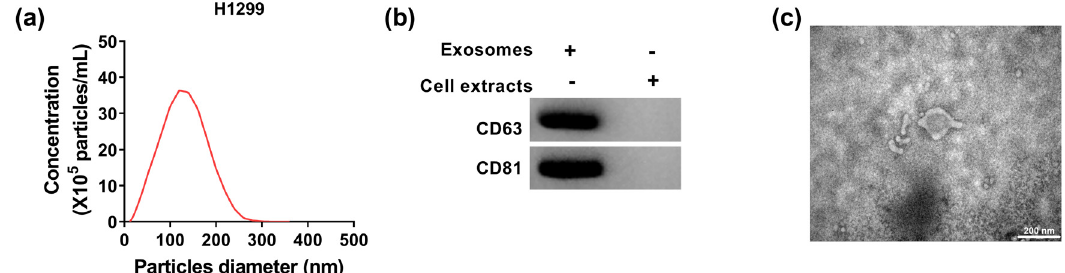
Figure 3: The exosomes are secreted by H1299 cells. Exosomes were isolated from the culture medium of H1299 cells. ( a ) The exosomes were con fi rmed by TEM. Scale bar: 200 nm. ( b ) The diameter of exosomes was analyzed. ( c ) CD63 and CD81 levels were detected via Western blotting in the exosomes from the culture medium of H1299 cells with or without pre - treatment of 20 μ M GW4869 for 2